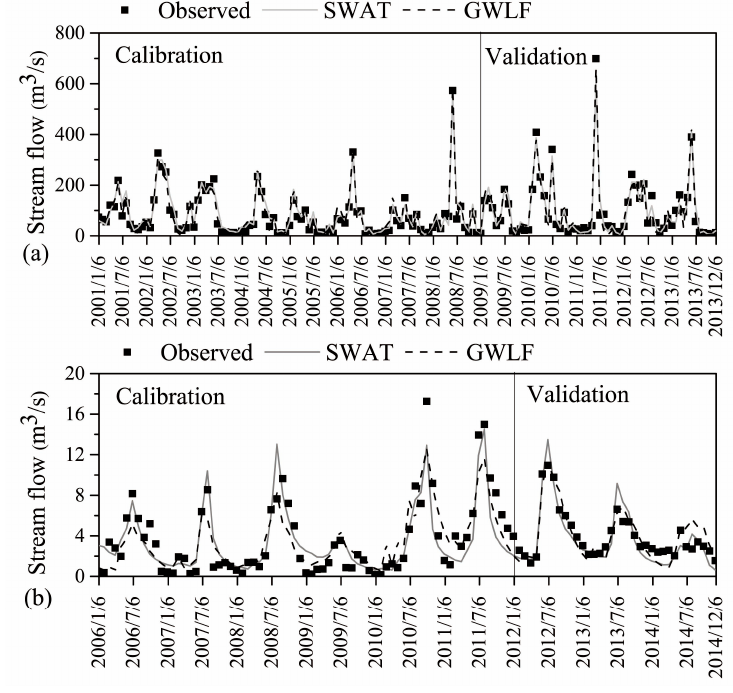
Figure 3. Simulated and observed monthly streamflow for: ( a ) Tunxi watershed; and ( b ) Hanjiaying watershed.